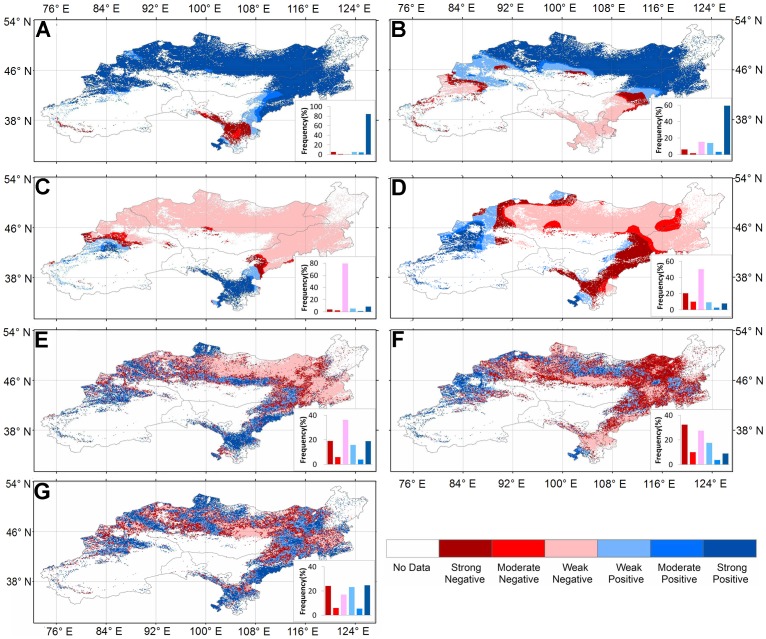
Spatial pattern of trends in meteorological variables, evapotranspiration, water balance and NDVI over the DEA region.(A)–(C) show spatial pattern of trends in mean annual air temperature, solar radiation, and average relative humidity from MERRA datasets, respectively. (D) shows the precipitation trends of GPCP dataset. (E) and (F) show the spatial pattern of trends in mean annual evapotranspiration and water balance respectively. (G) shows the trends in NDVI of growing season. The insets show the frequency distributions of corresponding trends.